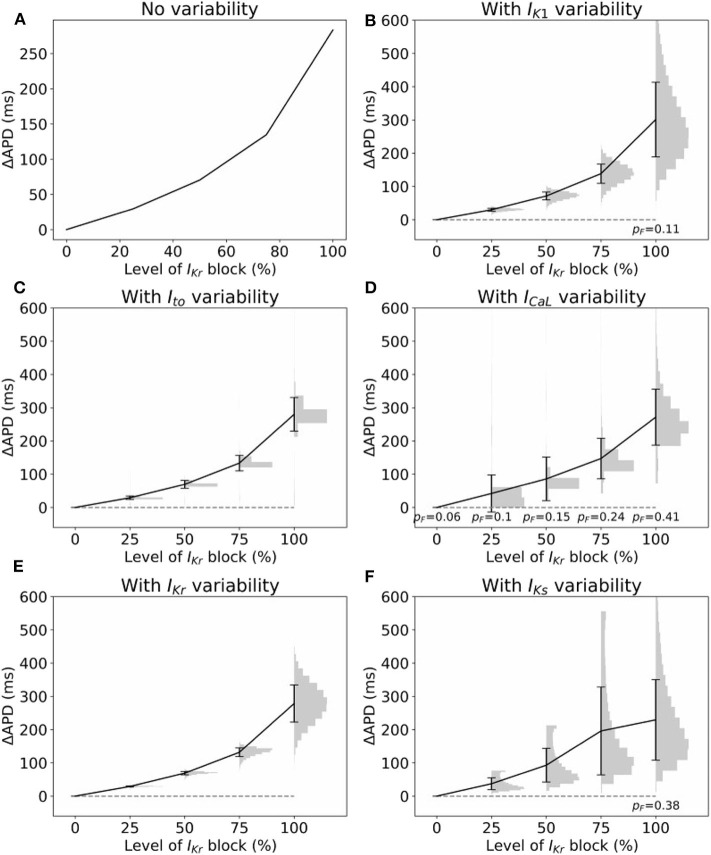
Impact of parameter variability on predictions of APD prolongation under block of IKr. (A) APD prolongation as a function of IKr block, with no variability accounted for. (B–F) Corresponding results considered variability in specific current, with parameters in other currents held fixed. Black lines are means, error bars are ±1 standard deviation, histograms show distribution of (ΔAPD | APD computable). In some cases APD was not computable (“failure”), because either control or block AP did not repolarize. pF represents probability of such failures. All histograms use 20 bins.